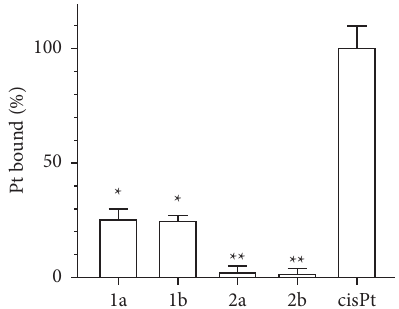
Figure 4: DNA binding of complexes 1a , 1b , 2a , 2b , and cisplatin with double-helical calf thymus DNA (c(Pt)/c(DNA nucleotides) � 0.02) in 10mM NaClO 4 at 37 ° C. Stars at the top of the bars indicate a statistically significant difference from cisplatin ( ∗ p ≤ 0 . 05, ∗∗ p ≤ 0 . 01). Data represent a mean ± SEM of two independent experiments, each measured in